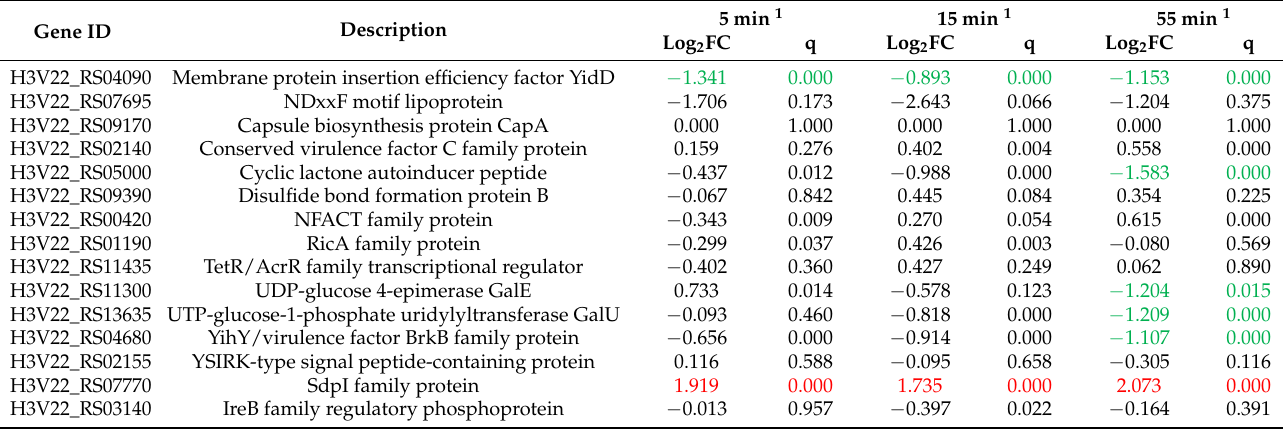
Table 3. Transcript levels of host virulence genes during phage SA1 infection.